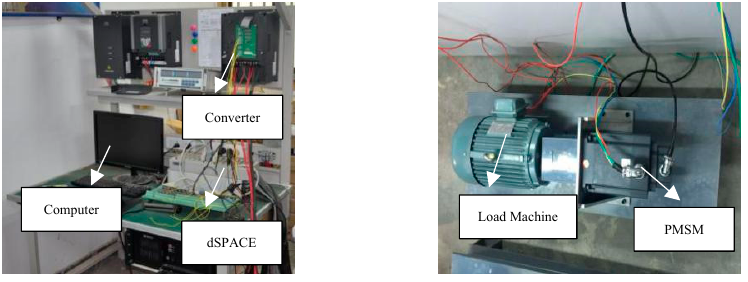
Figure 10. The controlled 6.5 kW PMSM drive test rig.